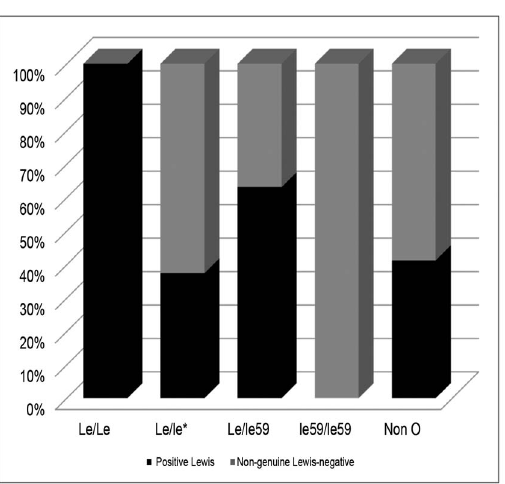
Figure 1. Genotype frequencies for the Lewis ( FUT3 ) gene and non-O blood groups in the positive and non-genuine Lewis- negative individuals.